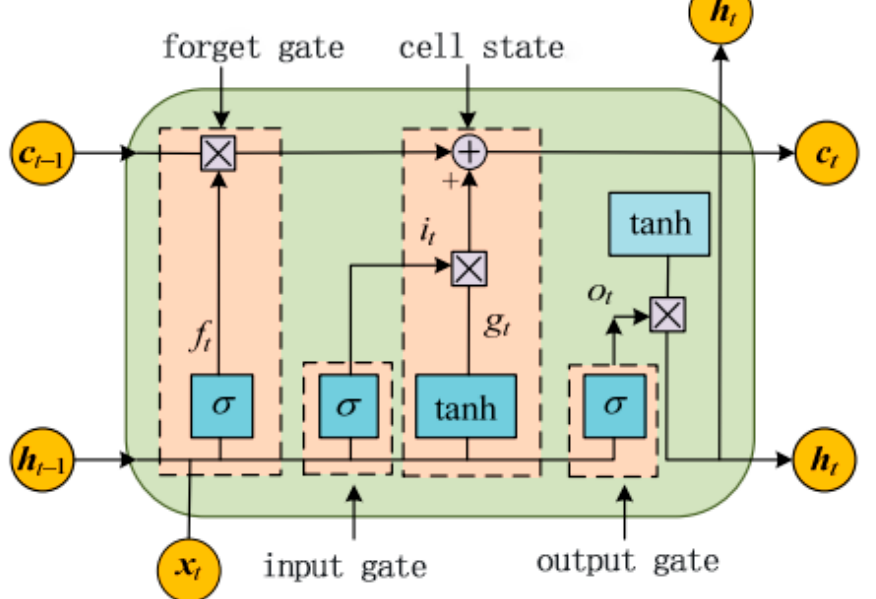
Figure 3. LSTM network structure.